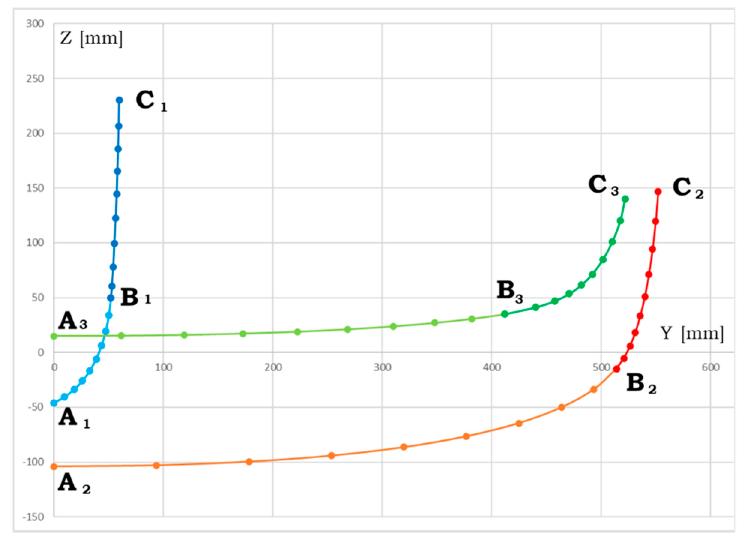
Figure 6. Structure of the curve of a section of the hull.